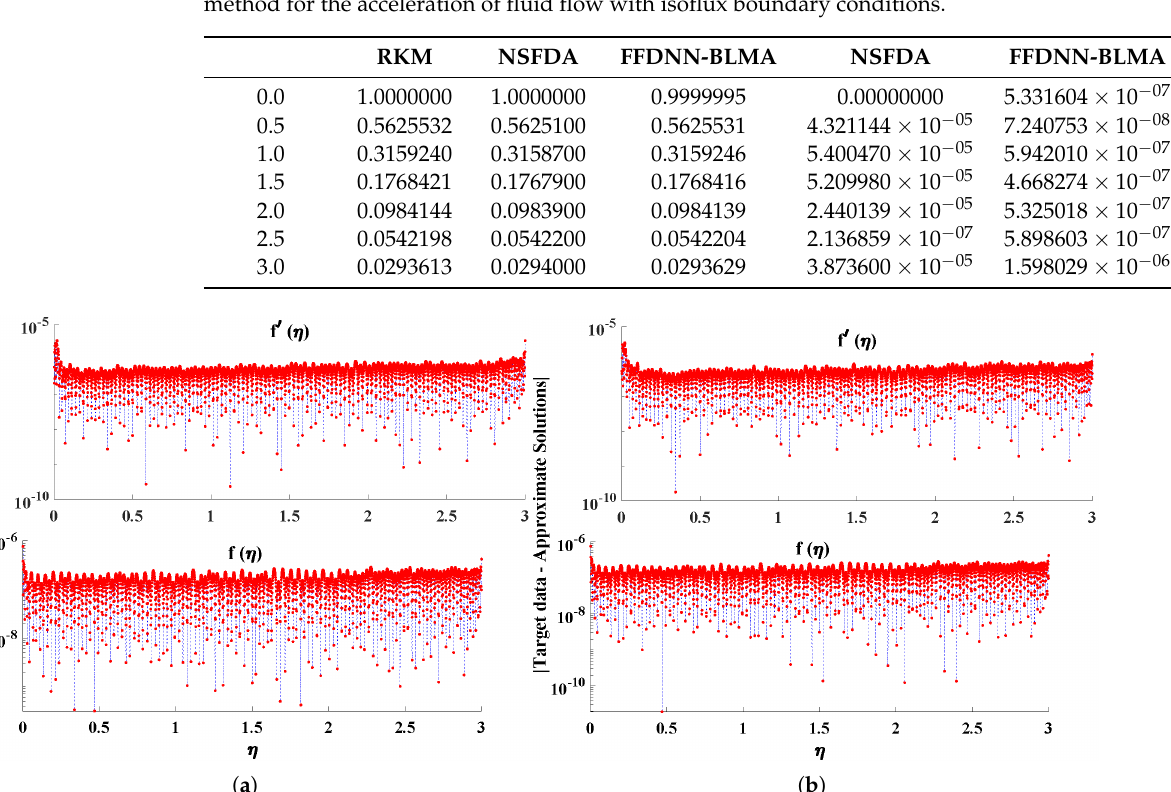
Figure 5. Comparison between the targeted solution and the predicted solution at 3001 datapoints for the fluid velocity and acceleration with ( a ) isothermal and ( b ) isoflux boundary